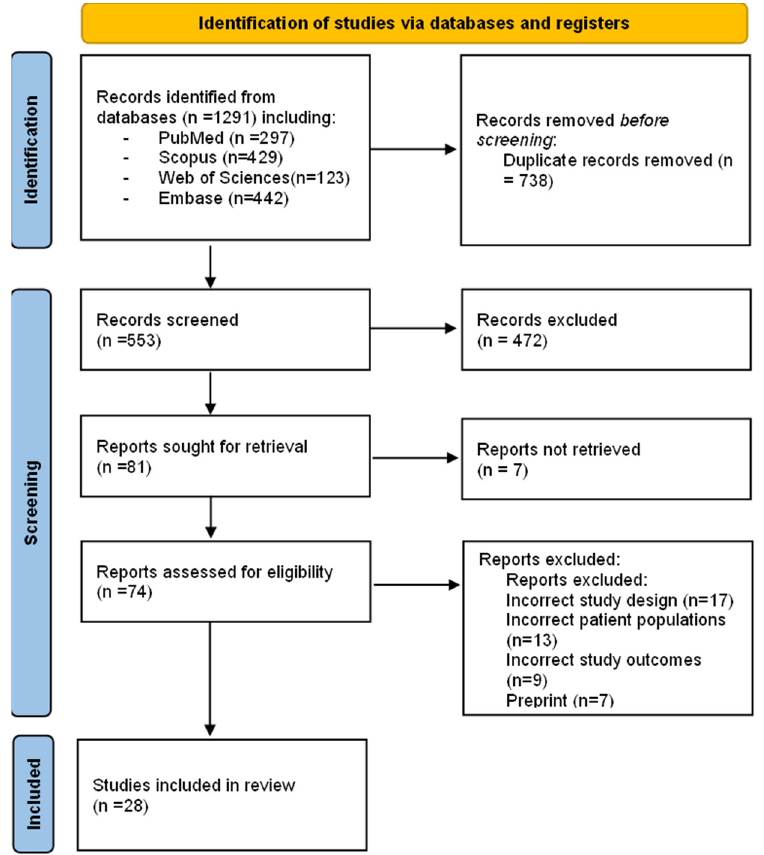
Figure 1. PRISMA flow chart of the studies selection process.